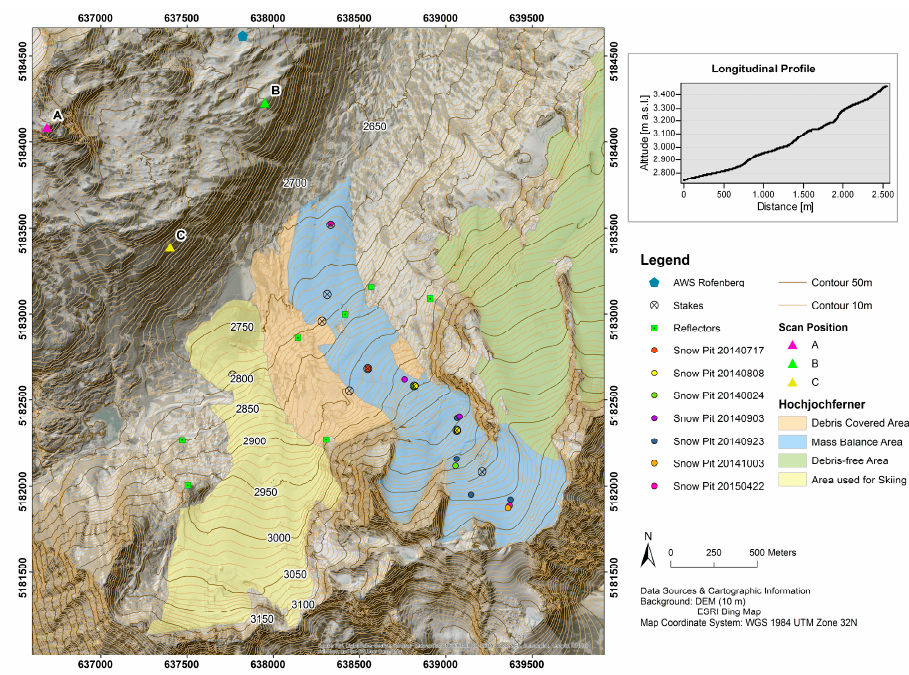
Figure 1. Overview map showing the surface divisions of the ice body that is called Hochjochferner. The part of Hochjochferner studied here is the mass balance area. Locations of Terrestrial Laser Scanner (TLS) scan positions, reflectors for georeferencing TLS scans, ablation stakes and snow pits are all shown. The map coordinate system is displayed as WGS1984 UTM Zone 32N, and the background of the map is a hillshade based on Airborne Laser Scanning (ALS) data, overlaid with an ESRI Bing Map.